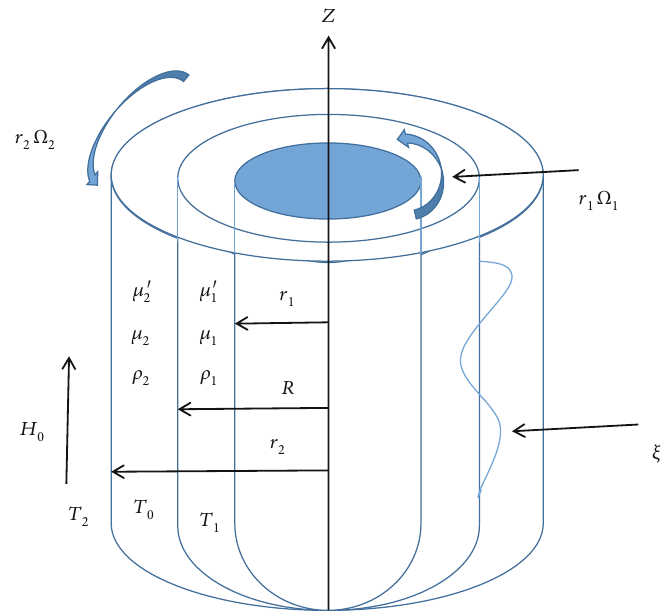
Figure 1: Schematic diagram of the